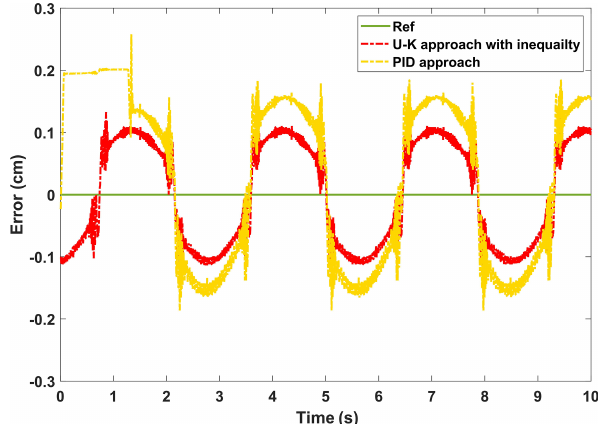
Figure 15. The control input of the steady-state performance of the U–K equality constraint and PID.